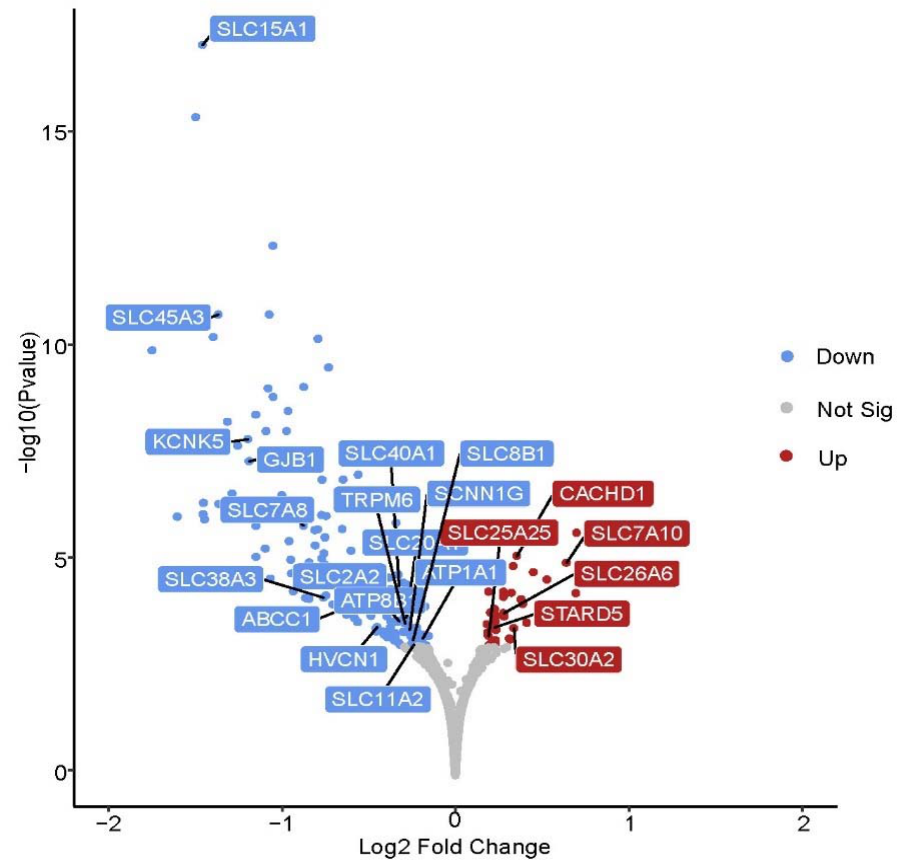
Figure 1. Volcano plot of the differentially expressed genes (DEGs) in female placentae. Blue, red, and grey dots denote downregulated ((FDR (false discovery rate) ≤ 0.1), upregulated (FDR ≤ 0.1), and non-differentially expressed (FDR > 0.1) genes in heat stress placentae ( n = 5) compared to control placentae ( n = 5). Gene symbols associated with placental transport activity are labelled. Table 2. A subset of differentially expressed genes in heat stress placentae ( n = 5) compared to control placentae ( n = 5). Gene